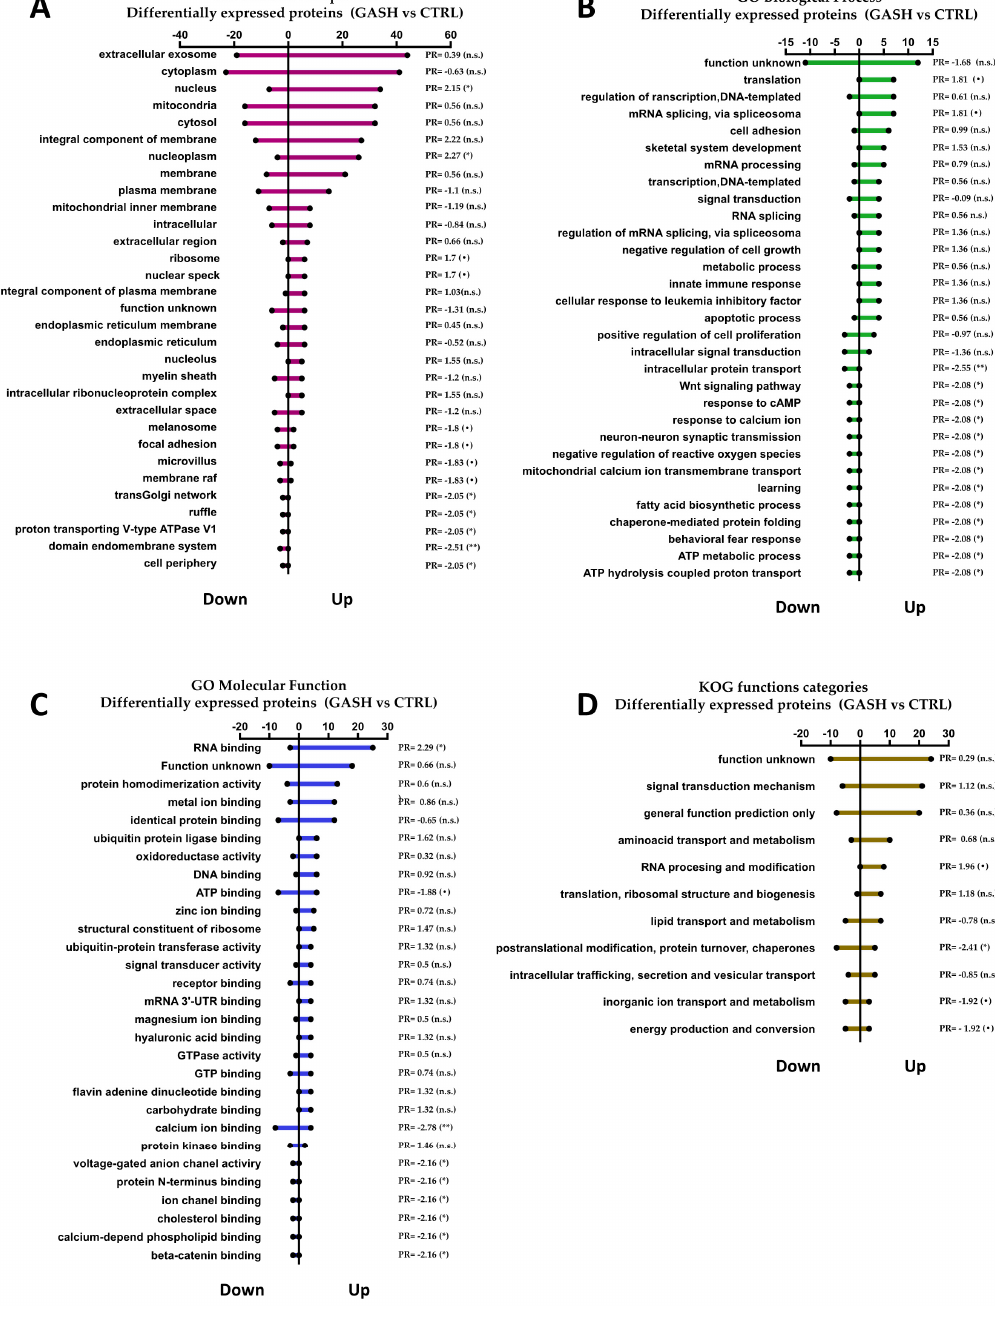
Figure 4. DEPs: GO analysis and KOG functions. The X -axis represents the number of DEPs up- and down-regulated in the IC in the GASH/Sal (GASH) vs . control (CRTL) hamster number of proteins, and the Y -axis represents the different annotation entries. The Chi -squared test assessed the rela- tionship between the groups (CTRL/GASH) and the annotation entries. ( A ) GO Cellular component; Chi -squared p -value = 0.02649. ( B ) GO Biological process; Chi -squared p -value = 0.0065. ( C ) GO Mo- lecular functions; Chi -squared p -value = 0.02649. ( D ) KOG functions; Chi-squared p -value = 0.16542. The PR (Pearson residual) shows the significance of variables between groups: • (90–95% confi- dence); * (95–97.5% confidence); ** (97.5–99% confidence); n.s. (no significant differences).